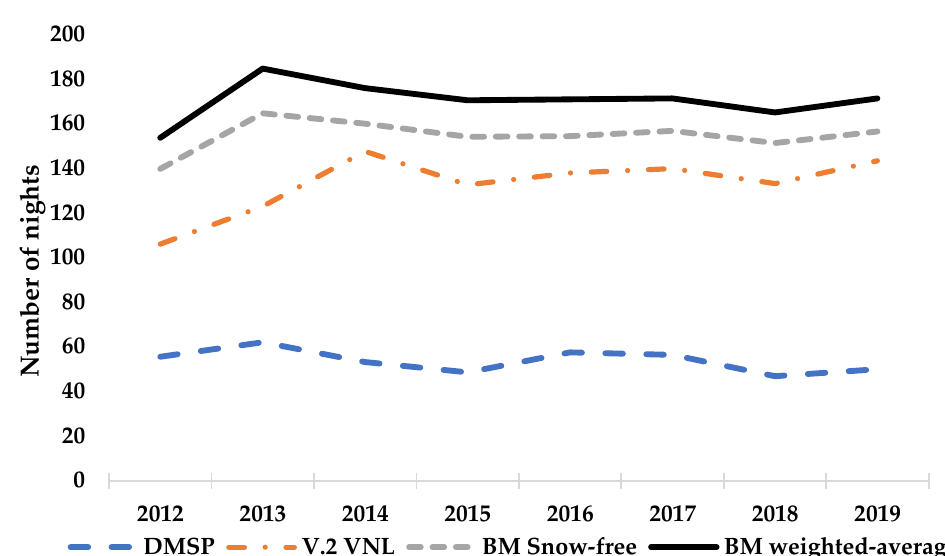
Figure 3. Average number of nights per year included in NTL composites for China.